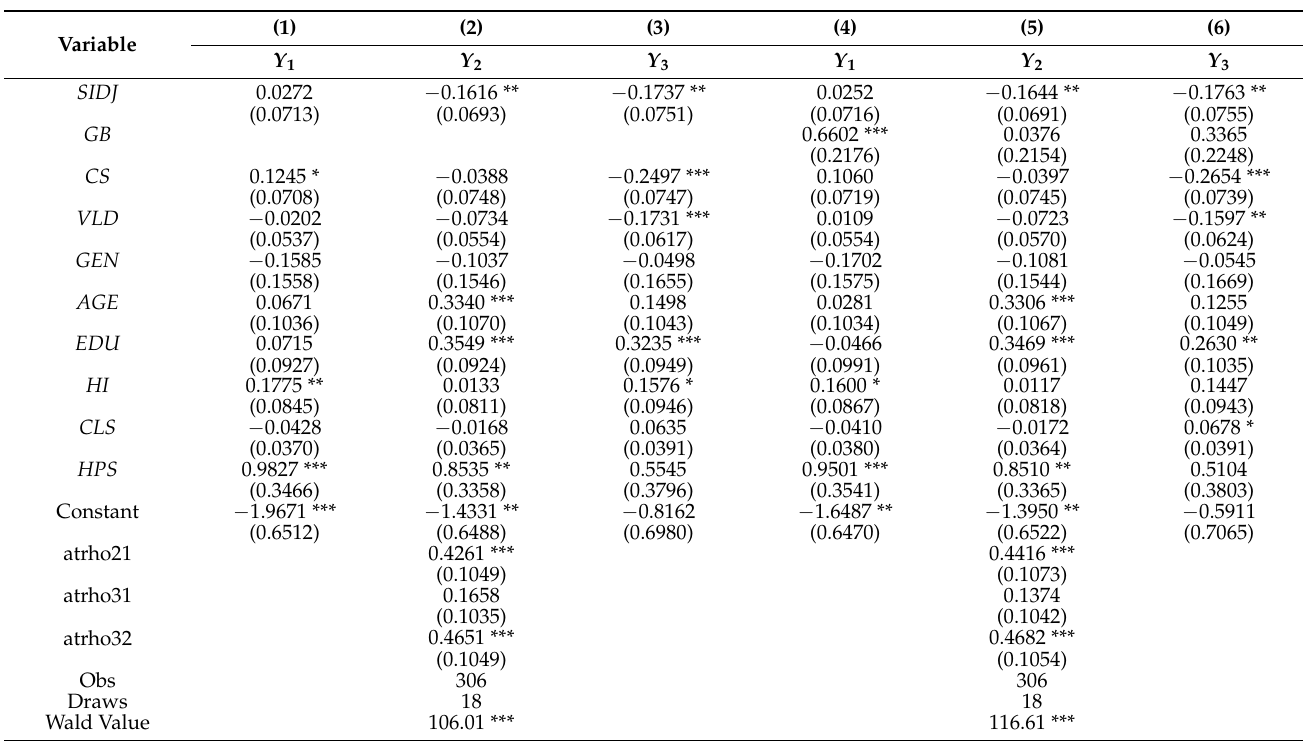
Table 4. MVP model robustness test